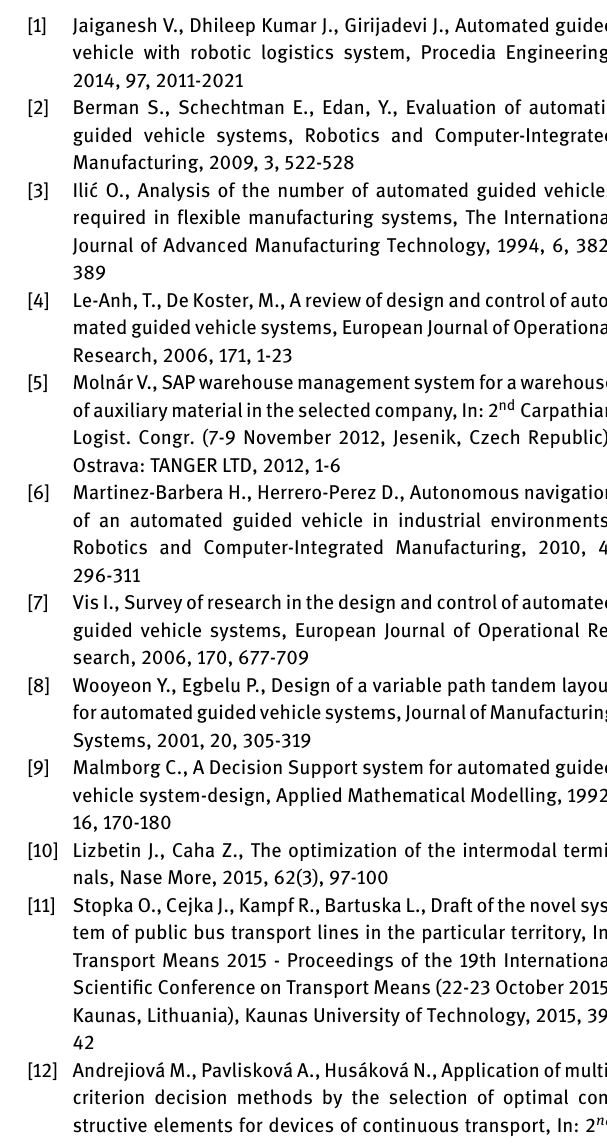
shifts), transport capacity in the number of trailers would increase, but the time utilization would remain constant at approximately 8% of the total operating time – 4 shifts after 8 hours (Fig.